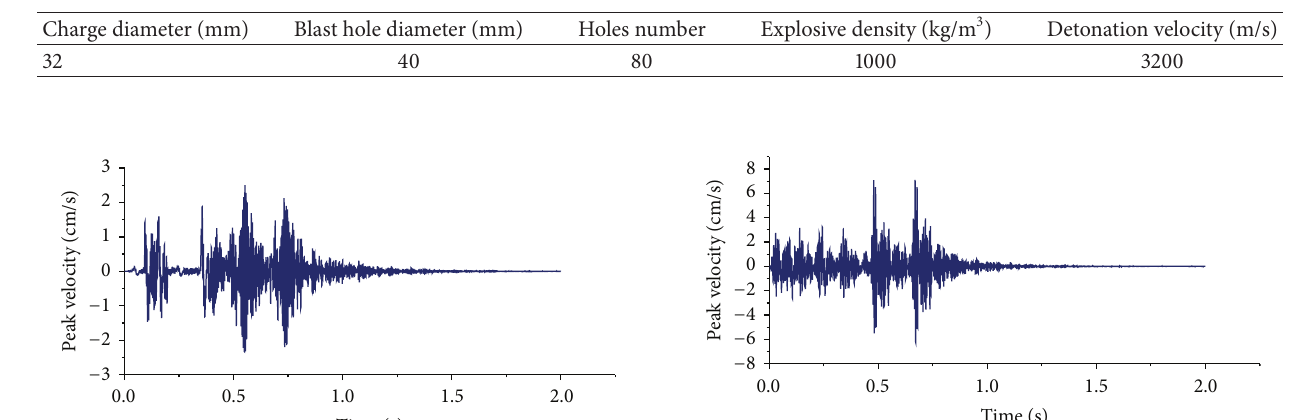
Table 1: Blasting parameters.